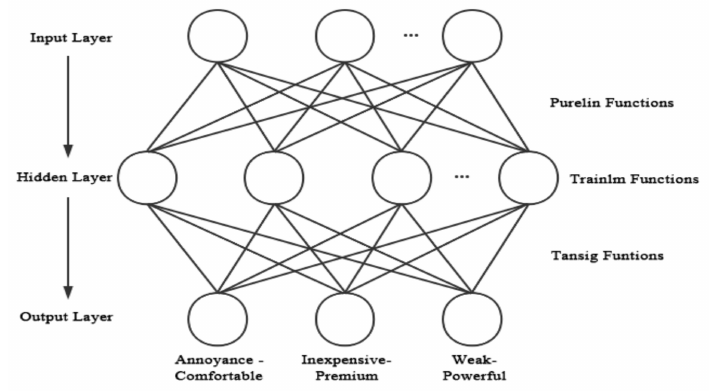
Figure 10. BPNN model prediction flow chart.